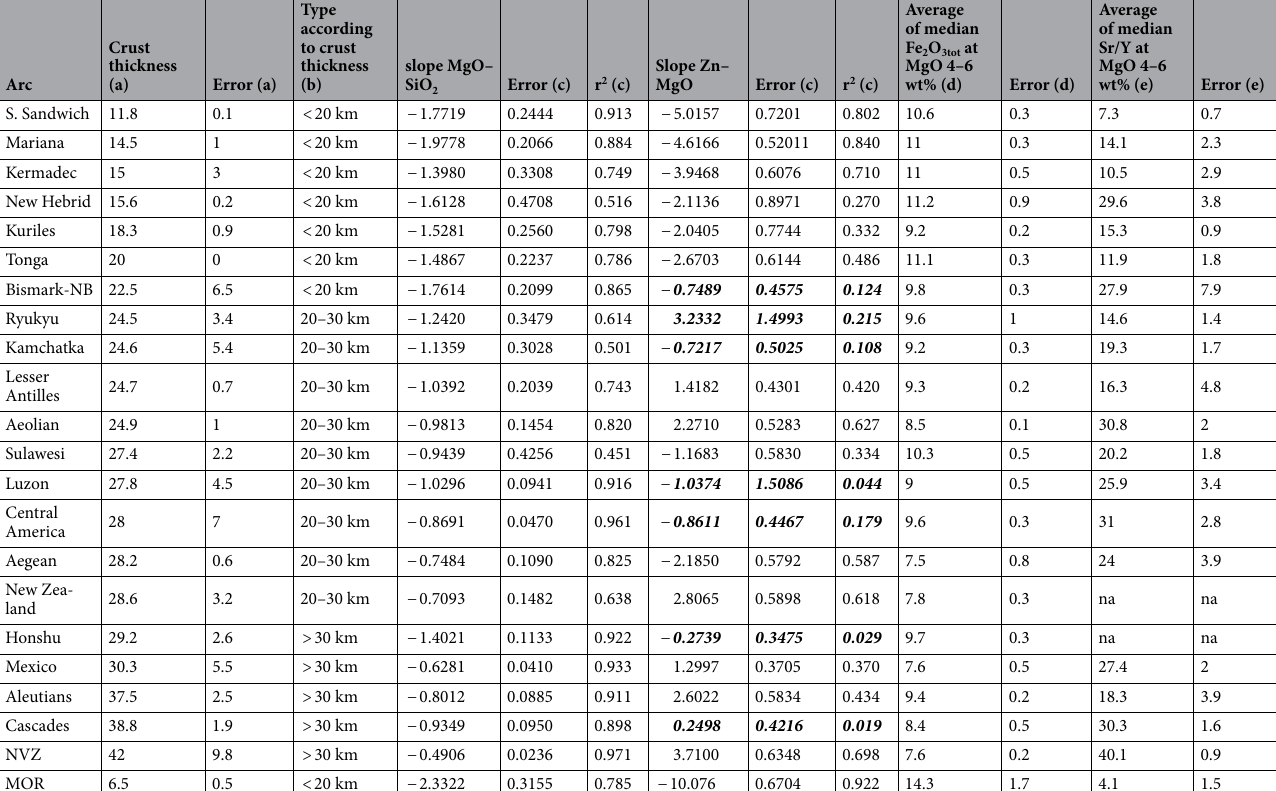
Table 1. Summary of the values of the regression slopes (MgO vs. SiO 2 and Zn vs. MgO) and associated statistical values. Bold and italics indicate poor statistical correlations (see Supplementary Figure S1). (a) From 64 , except Tonga thickness, which is from 65 , Kermadec thickness, which is from 66 , Aleutians thickness which is from 67 , and Northern Andes thickness which is from 68 . The Tonga crustal thickness here taken corresponds to the maximum crustal thickness of 65 because arc magmatism occurs in coincidence with the thickest part of the Tonga arc (Fig. 9 in 65 ). Crustal thicknesses have been calculated by 64 using the global crustal model at 2° × 2°, CRUST 2.0, administered by the US Geological Survey and the Institute for Geophysics and Planetary Physics at the University of California 69 , which is an updated version of CRUST 5.1, a global crustal model at 5° × 5° 70 .The model is based on seismic refraction data published up to 1995 and a detailed compilation of sediment thickness. The crustal thicknesses of 64 are within the ranges of crustal thicknesses reported in previous studies 71,72 with which they show good linear correlations (r = 0.70 with respect to crustal thicknesses of 71 , and r = 0.74 with respect to crustal thicknesses of 72 ). Oceanic crust thickness is from. (b) Attribution to a crust thickness type takes into account the 1σ uncertainty and the geochemical systematics: for instance, Bismark/New Britain has average crust thickness slightly above 20 km, but taking into account the 1 uncertainty minimum values are largely < 20 km and geochemical trends are more typical of arcs < 20 km thick. This subdivision is purely semantic and does not change the mathematical correlations. (c) errors and correlation coefficients r 2 of the regressions were calculated using the "LINEST" function in Excel. (d) From 7 . (e) Fromy 8